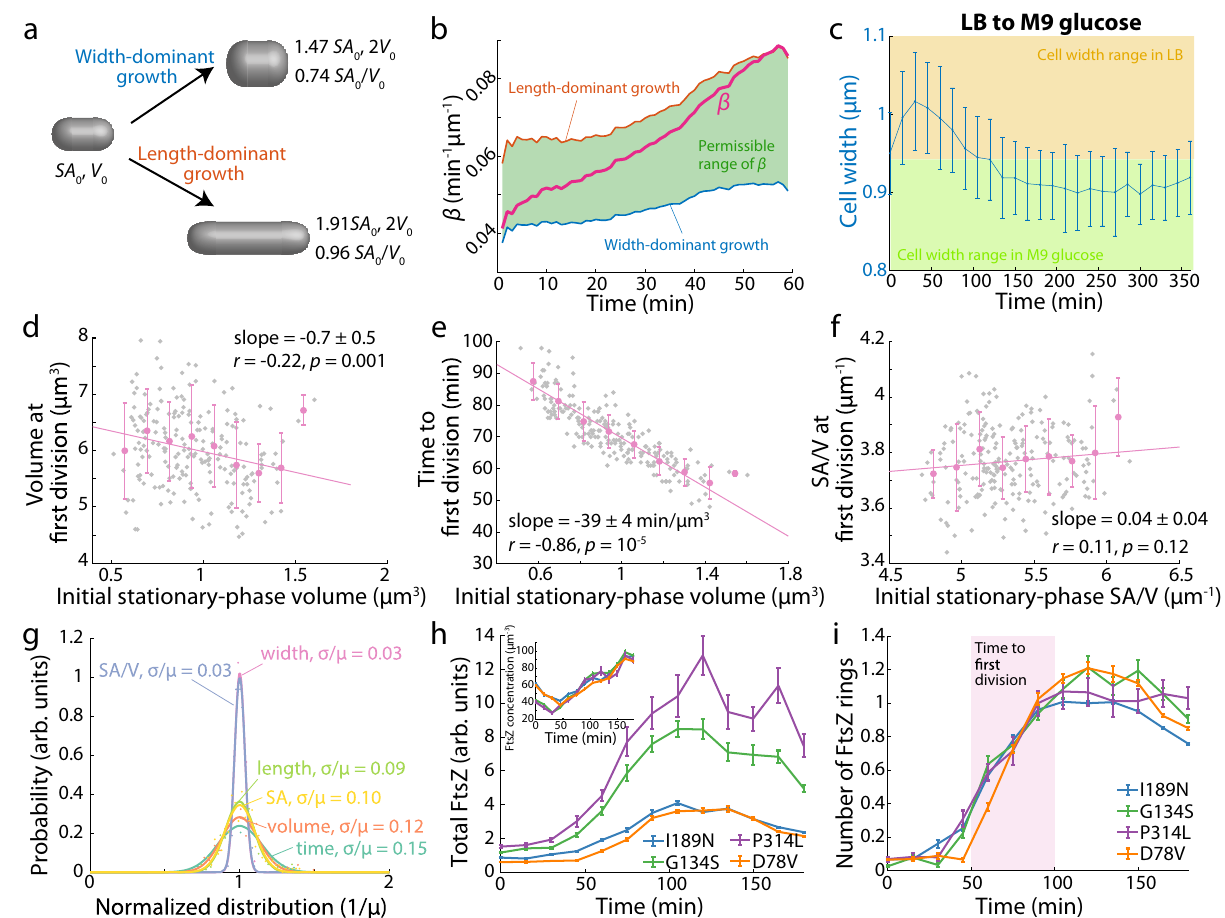
Fig. 3 SA/V dynamics are correlated with the fi rst cell division after stationary phase exit. a For a rod-shaped cell starting with surface area SA 0 and V 0 , doubling its volume by expansion in width requires a 47% increase in surface area (top), whereas expansion in length requires a 91% increase in surface area (bottom). Therefore, an increase in width minimizes the surface area requirement for a given amount of volumetric growth. b Given the geometry and instantaneous growth rate ( α ) of cells in Fig. 1d, to maintain rod-like shapes, only a certain range of β values are permissible (green, Methods). The actual value of β started close to its minimal possible value, characterizing a widening-dominant growth mode; by 60 min, β reached its maximum possible value, transitioning to an elongation-dominant growth mode. c Dilution of stationary-phase cells grown in LB into M9 glucose caused an increase in cell width, despite the fact that cells continuously passaged in M9 glucose always had lower cell width than the LB-grown stationary-phase cells. Data are mean ± S.D. with n > 100 cells. d – f For cells exiting stationary phase, the volume at the fi rst division was negatively correlated with the starting volume ( d ). The time to fi rst division after stationary-phase exit was negatively correlated with the initial cell volume ( e ). The SA/V at the fi rst division was largely constant and independent of the initial SA/V of stationary-phase cells ( f ). Gray dots are data points for n = 209 individual cells, and pink data points are binned mean and S.D. values, which were fi t to a linear model. Data for slopes are mean ± s.e.m. r, Pearson ’ s r . p -values are from two-tailed Student ’ s t tests. g Normalized distributions of cell length, width, SA, volume, SA/V, and time at fi rst division after stationary-phase exit. SA/V and width had by far the narrowest distributions. h FtsZ abundance was measured as total fl uorescence intensity inside cells. The dynamics of FtsZ regulation were similar across mutants. FtsZ abundance did not change in the fi rst ~50 min, then increased to a maximum at ~100 min. Inset: While larger cells tended to have lower SA/V and higher FtsZ levels, FtsZ concentrations were highly similar across shape mutants. Data points are mean ± s.e.m. with n > 200 cells. i All strains started without FtsZ rings and did not possess a ring until ~50 min post dilution, consistent with the onset of fi rst divisions after stationary phase exit ( e ). By 100 min, virtually all cells had ~1 FtsZ ring. Data points are mean ± s.e.m. with n > 200 cells. Source data are provided as a Source Data fi wild-type E. coli , despite their altered lengths and widths measurements in exponential-phase cells 11 . In all strains, no FtsZ (Supplementary Fig. 2g). Total FtsZ fl uorescence remained rings were observed until ~50 min post dilution. Virtually all cells contained one FtsZ ring by ~100 min post dilution (Fig. 3i), constant in the fi rst 45 min post dilution before starting to consistent with the observed timing of the fi rst division after increase (Fig. 3h), indicating that FtsZ synthesis started much stationary-phase exit (Fig. 3e). Taken together, these data indicate later compared to other genes (Fig. 2e). We also measured FtsZ that FtsZ levels are upregulated concurrent with the need for dynamics in a time-lapse experiment with GFP fused to the FtsZ division. promoter (P ftsZ -GFP) 24 and con fi rmed that FtsZ expression started ~50 min post dilution (Supplementary Fig. 2h). Although the four MreB mutants had different levels of total FtsZ (Fig. 3h), SA/V dynamics are broadly conserved across width and length FtsZ concentration was quantitatively similar across the different perturbations . Since SA/V is dependent on both cell width and strains (Fig. 3h, inset), suggesting a conserved mechanism of FtsZ length, we asked whether chemically or genetically tuning cell width or length would affect SA/V dynamics. We fi rst treated regulation independent of cell shape, consistent with previous